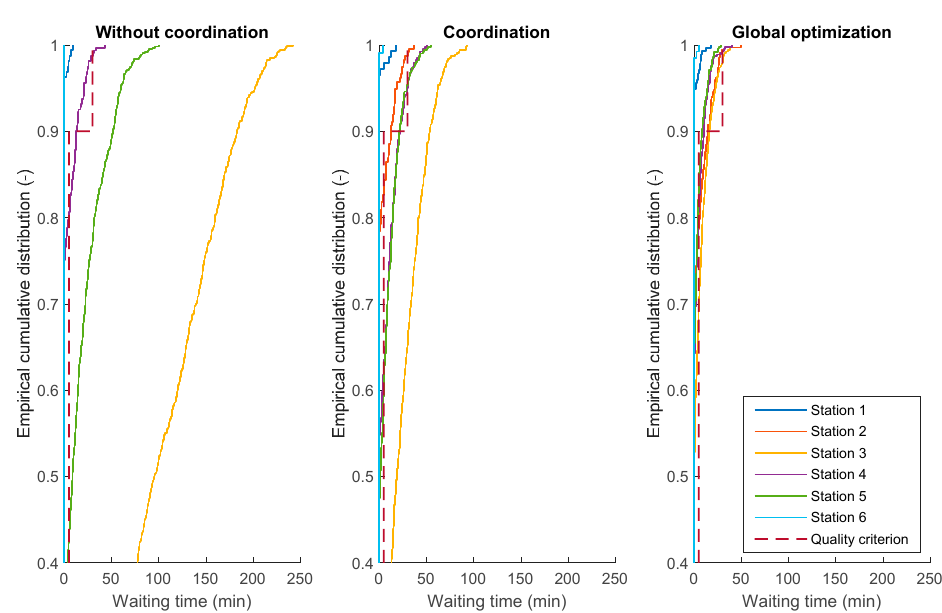
Figure 14. Waiting times at charging station, 2 charging points per station.